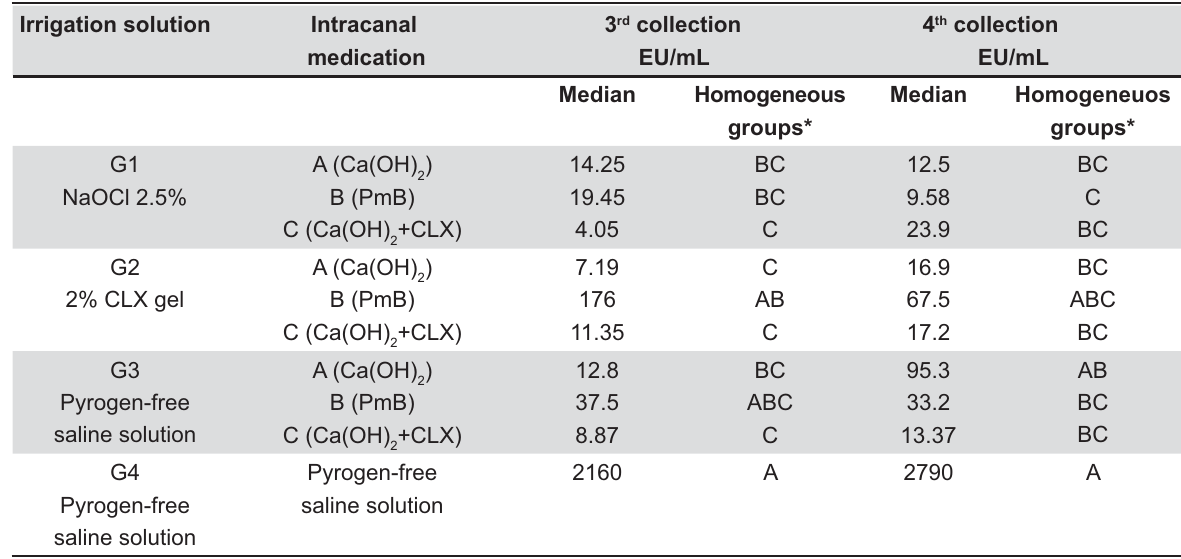
Table 3- Descriptive statistics of the median and homogeneous groups of quantity of endotoxin of E. coli (EU/mL) on